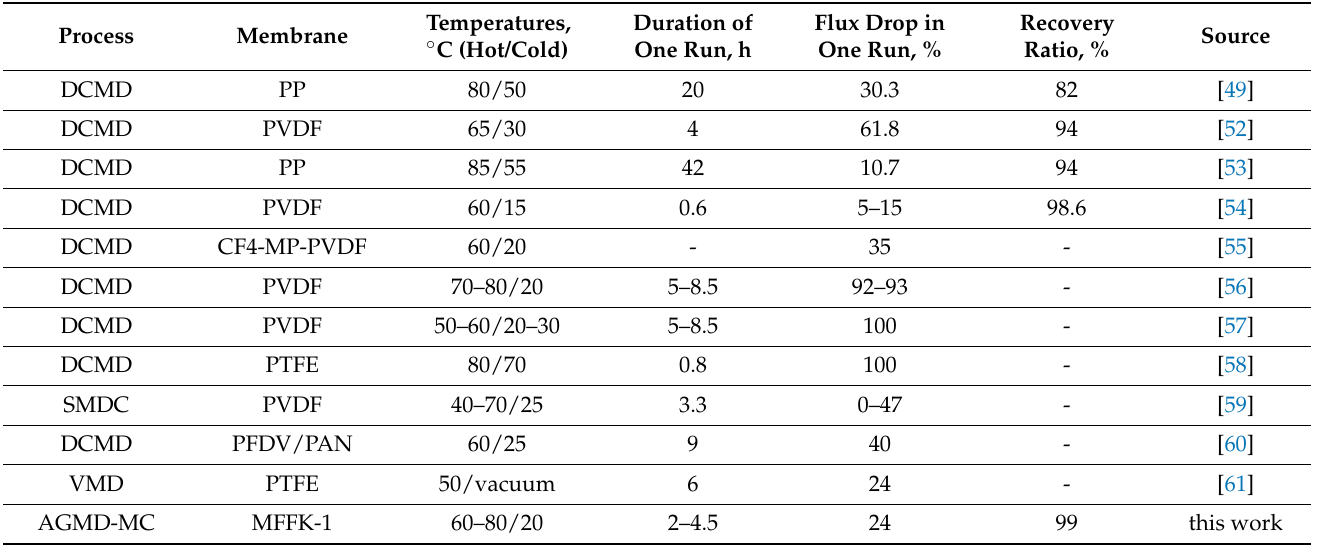
Table 3. Comparison of performance drop in the membrane distillation with crystallization for NaCl saturated solution.